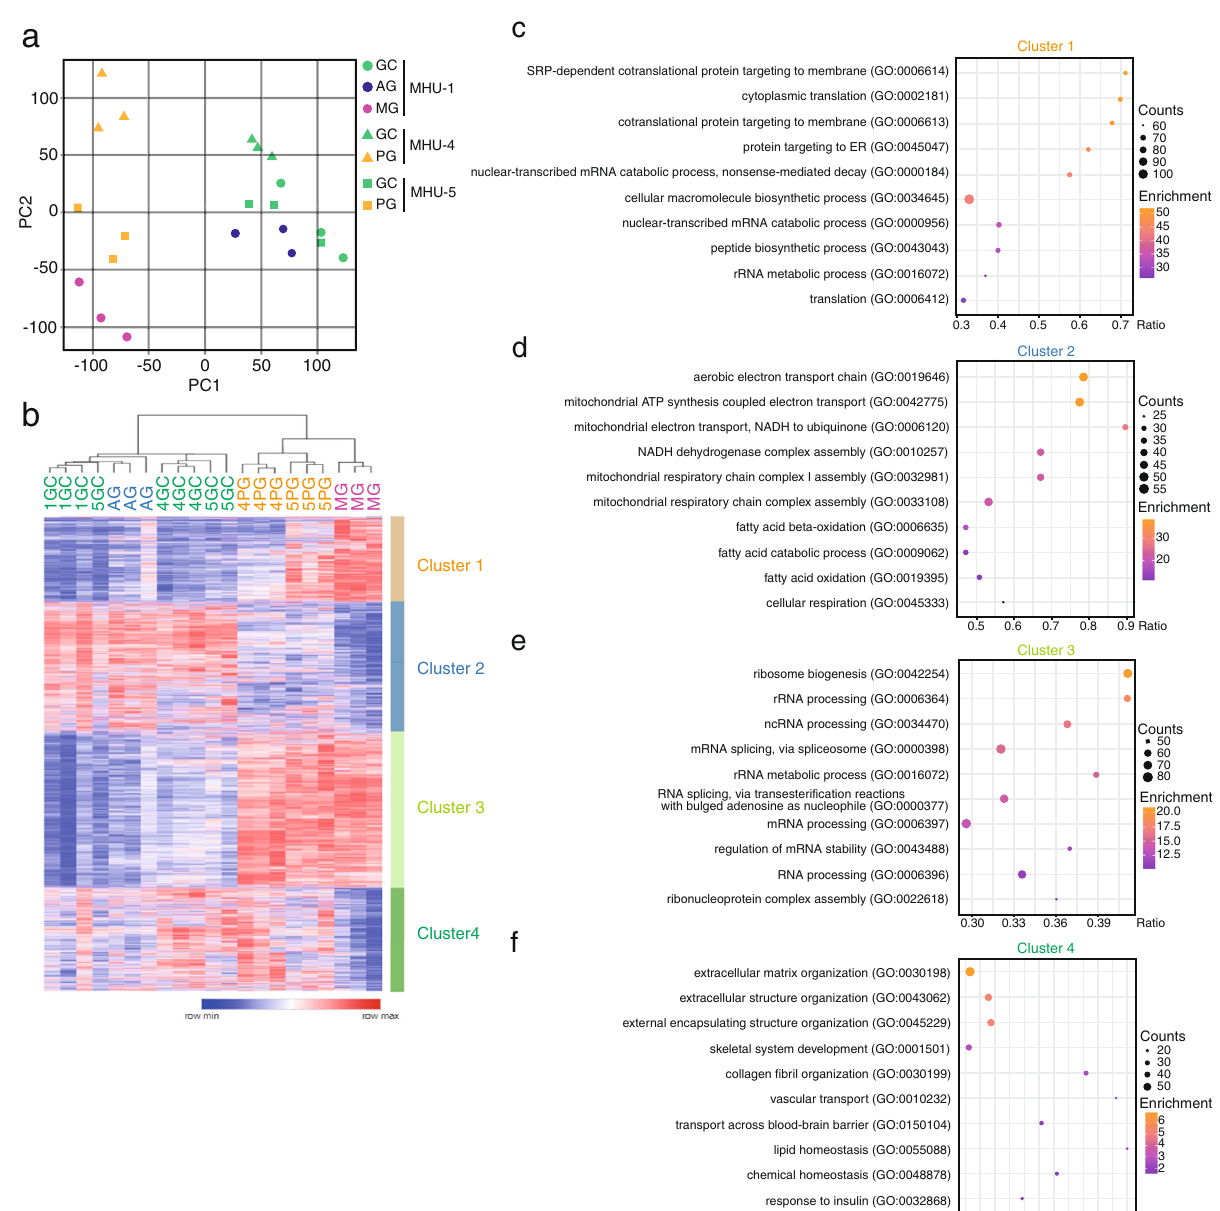
Fig. 3 Comprehensive RNA sequencing analysis under conditions of microgravity and lunar gravity. a Principal component (PC) analysis plots of gene expression of the soleus muscle of mice in mouse habitat unit (MHU)-1, -4, and -5 missions. b Clustering heatmap of 7138 differentially expressed genes between MHU-1_MG vs. MHU-1_GC. 1GC: MHU-1_GC; 4GC: MHU-4_GC; 5GC: MHU-5_GC; MG: MHU-1_MG; AG: MHU-1_AG; 4PG: MHU-4_PG; 5PG: MHU-5_PG. c – f Gene Ontology analysis of each gene cluster. (Fig. 2b – d), we investigated whether 1/6 g was suf fi cient to pre- vent microgravity-induced slow-to-fast myo fi ber transition. Cross sections of the Sol and EDL muscles were immunostained with antibodies against type I, IIa, and IIb. Fibers not identi fi ed as type I, IIa, or IIb were de fi ned as type IIx. ” (Fig. 5a, Supplementary Fig. 5a). The percentage of type IIa and IIb myo fi bers in the Sol muscle was 43% lower and 1000% higher, respectively, in MG mice than in GC mice (Fig. 5b), indicating slow-to-fast myo fi ber transition during space fl ight. These changes were competently abolished in AG mice. The altered IIa:IIb ratio in MG mice was partially reverted in PG mice. The EDL muscle myo fi bers were not affected by space fl ight (Supplementary Fig. 5b).